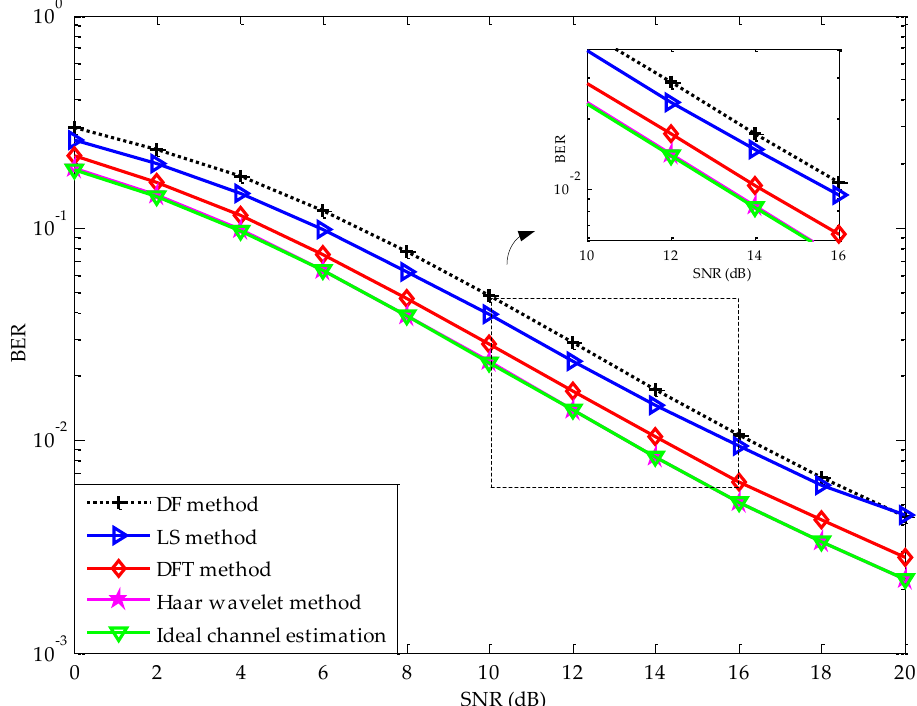
Figure 8. BER performance of QPSK modulated CP-OFDM and wavelet-OFDM systems under CDT6 channel.